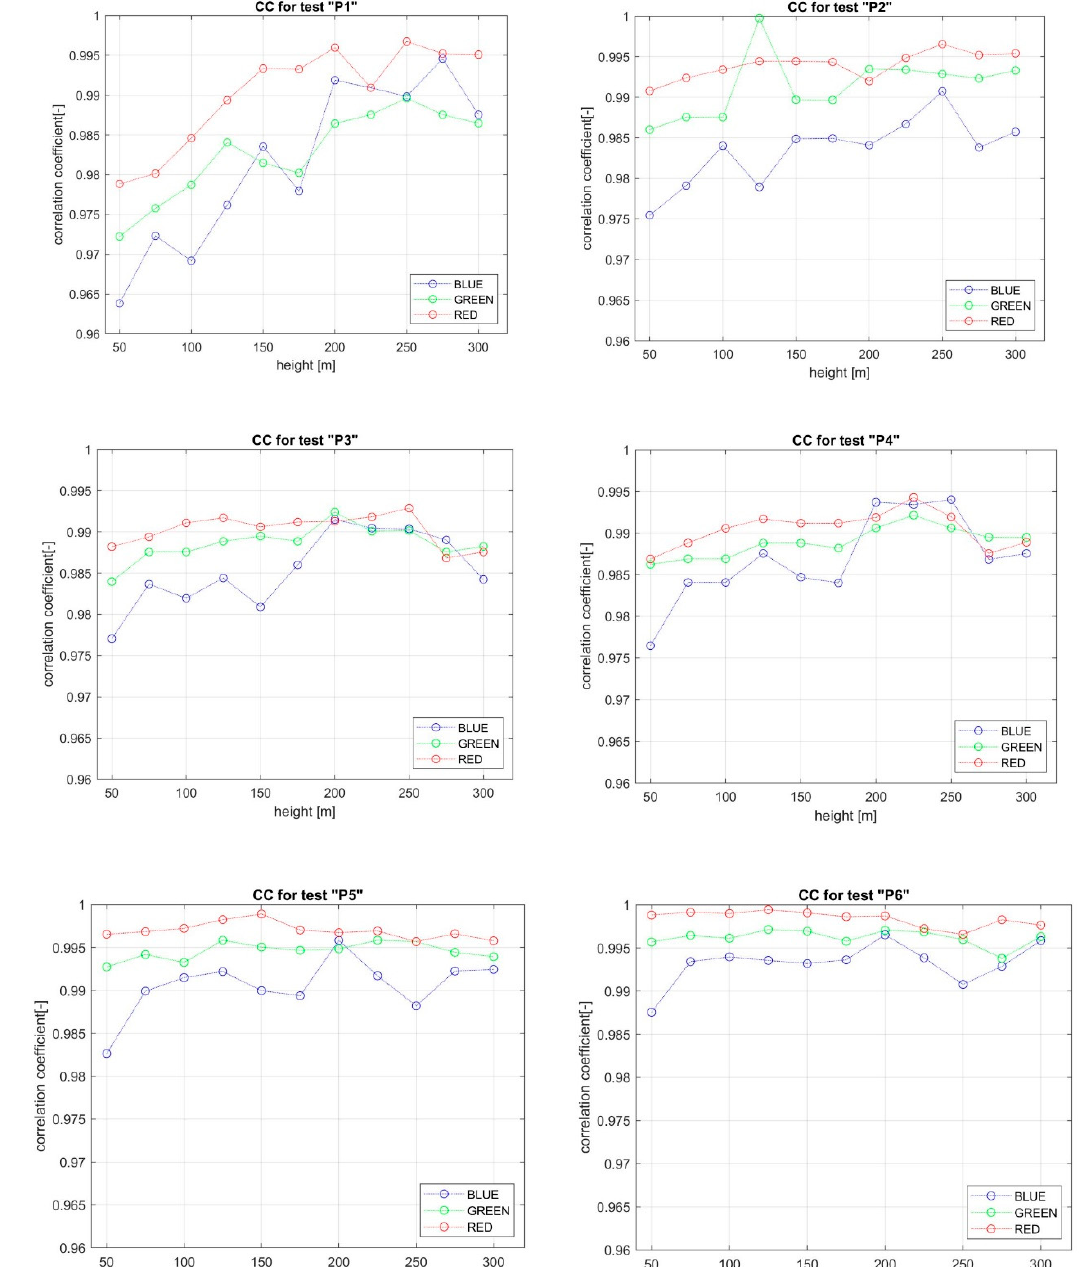
Figure 11. Correlation coefficient (CC) for humidity change function and electromagnetic wave reflection coefficient during the day at different unmanned aerial vehicle (UAV) flight altitudes for the calibration test with known spectral characteristics in the Mieruniszki test area (obtained September 13, 2018) .